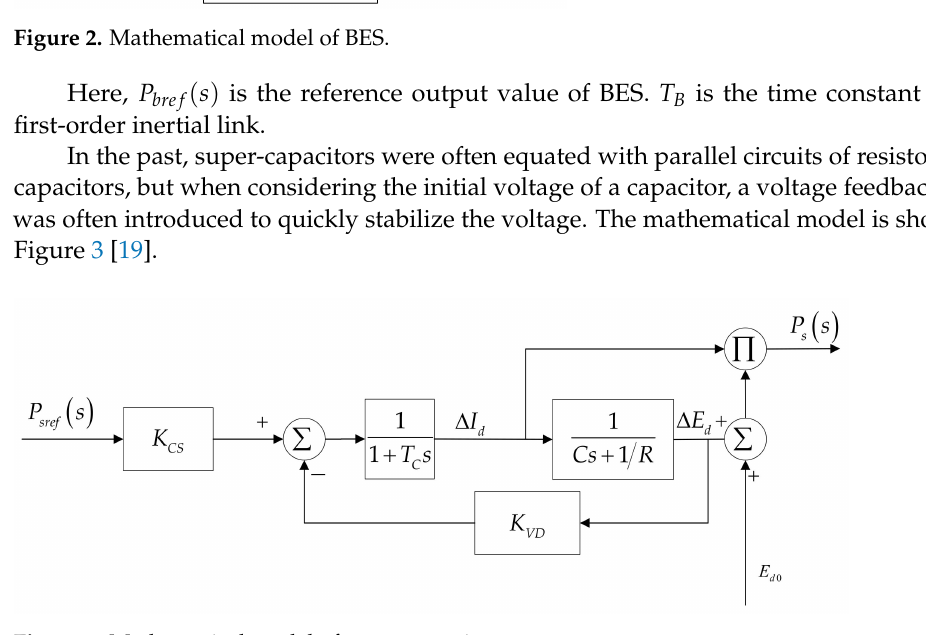
Figure 3. Mathematical model of